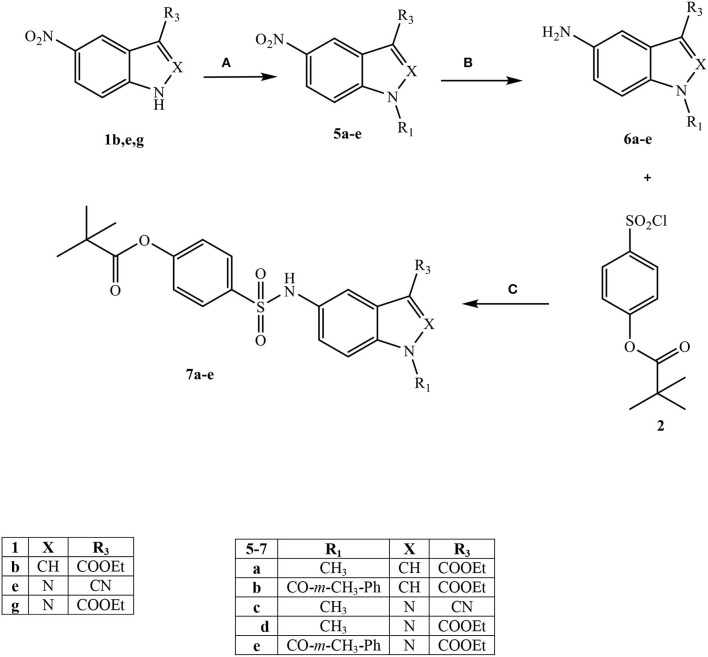
aReagents and conditions. (A) for 5a,c,d: CH3I, Na2CO3, anhydrous CH3CN, 80 C, 6 h; for 5b:
m-Toluoyl chloride, NaH (60% dispersion in mineral oil), anhydrous THF, r.t., 24 h; for 5e:
m-Toluoyl chloride, Et3N, anhydrous CH2Cl2, 0°C, 2 h then r.t., 2 h (B) H2 (Parr), Pd/C, EtOH 96%, 30 min (for 6c) and 2 h (for 6a,b,d,e); (C) for 7a,b: Et3N, anhydrous CH2Cl2, 0°C, 2 h then r.t., 2 h; for 7c-e: dry pyridine, r.t., 4 h.